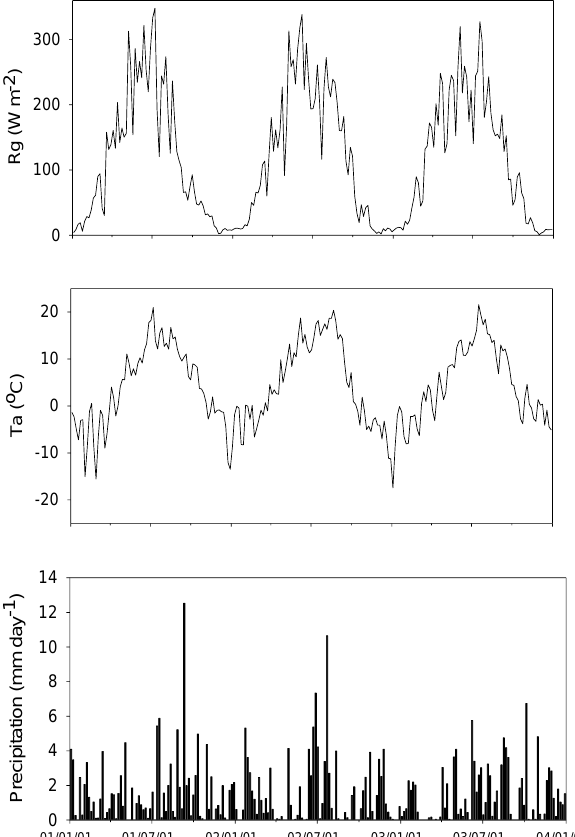
Fig. 1. Observed global radiation ( R g ) (upper), air temperature ( T a ) (center) and precipitation (lower) during 2001–2003. All values are 5-day averages.